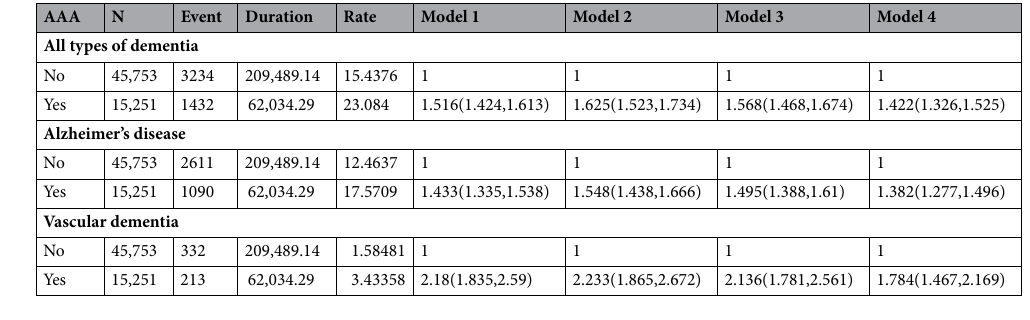
Table 2. Hazard ratio of AAA for incidence of dementia. AAA Abdominal aortic aneurysm. Model 1 adjusted for age and sex, Model 2 adjusted for age, sex, income level, diabetes, hypertension, and dyslipidemia. Model 3 adjusted for age, sex, income level, diabetes, hypertension, dyslipidemia, smoking status, alcohol consumption, exercise status, and BMI. Model 4 adjusted for age, sex, income level, diabetes, hypertension, dyslipidemia, smoking status, alcohol consumption, exercise status, BMI, and history of